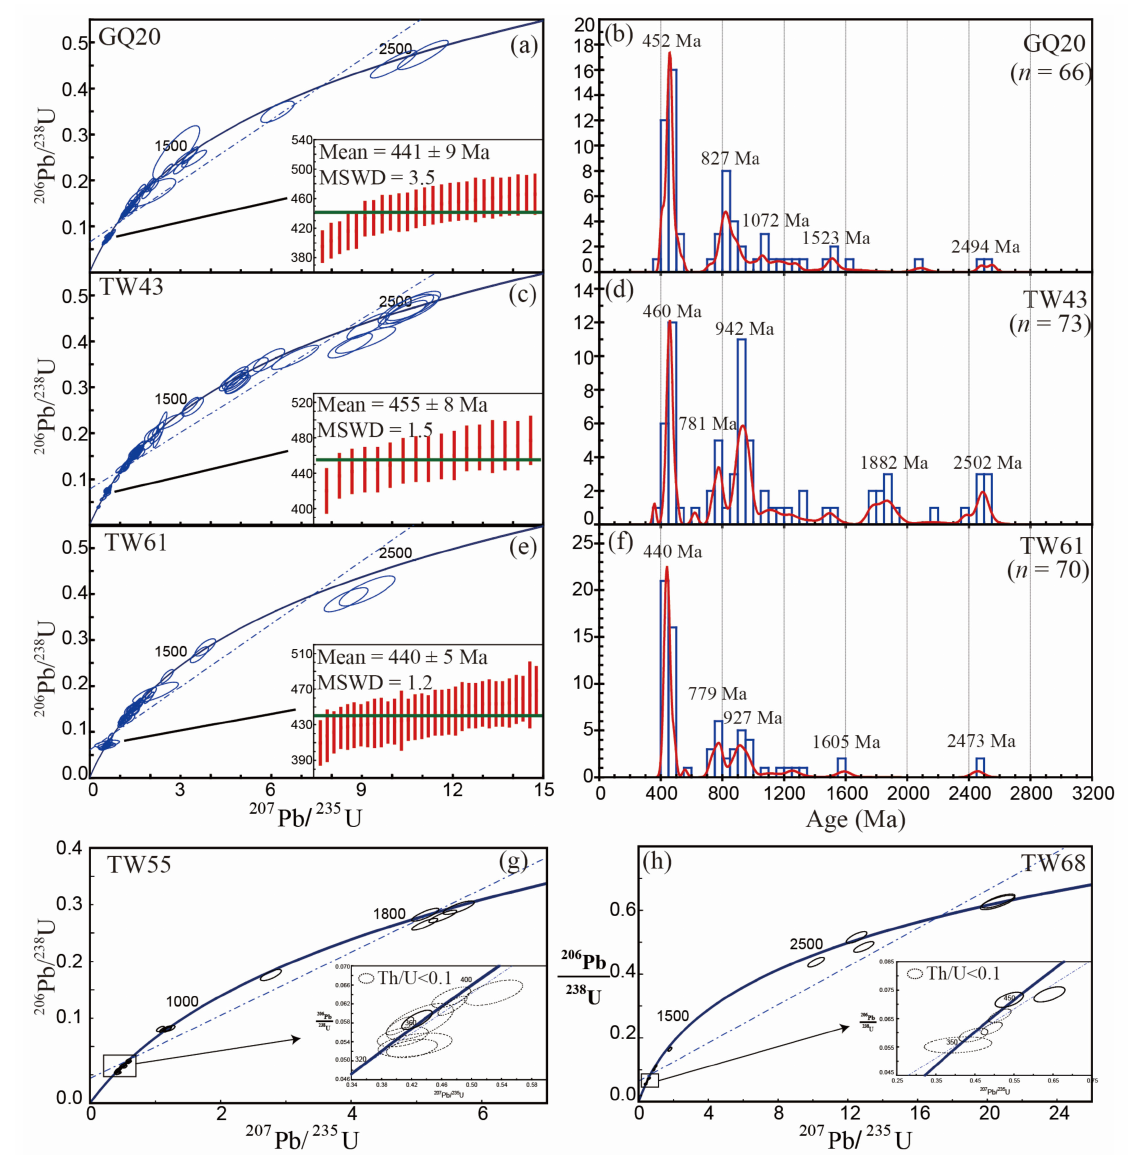
Figure 4. Zircon U–Pb concordia diagrams ( a , c , e , g , h ) and relative probability plots of U–Pb ages ( b , d , f ) for concordant detrital zircon grains from the Wuguan Complex and Liuling Group. Zircons from sample TW43 were mostly colorless or transparent, with a